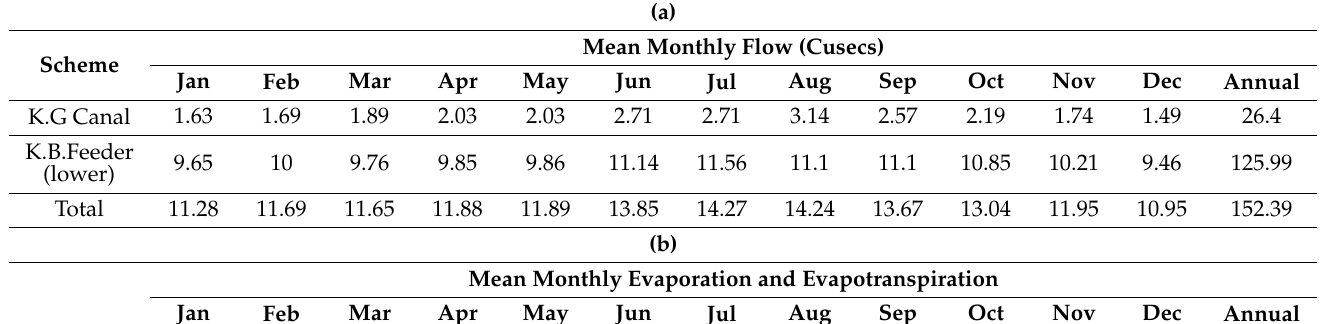
Table 1. ( a ) Long term mean monthly flow of Keenjhar Lake; ( b ) long term mean monthly evaporation and evapotranspiration of Keenjhar Lake.